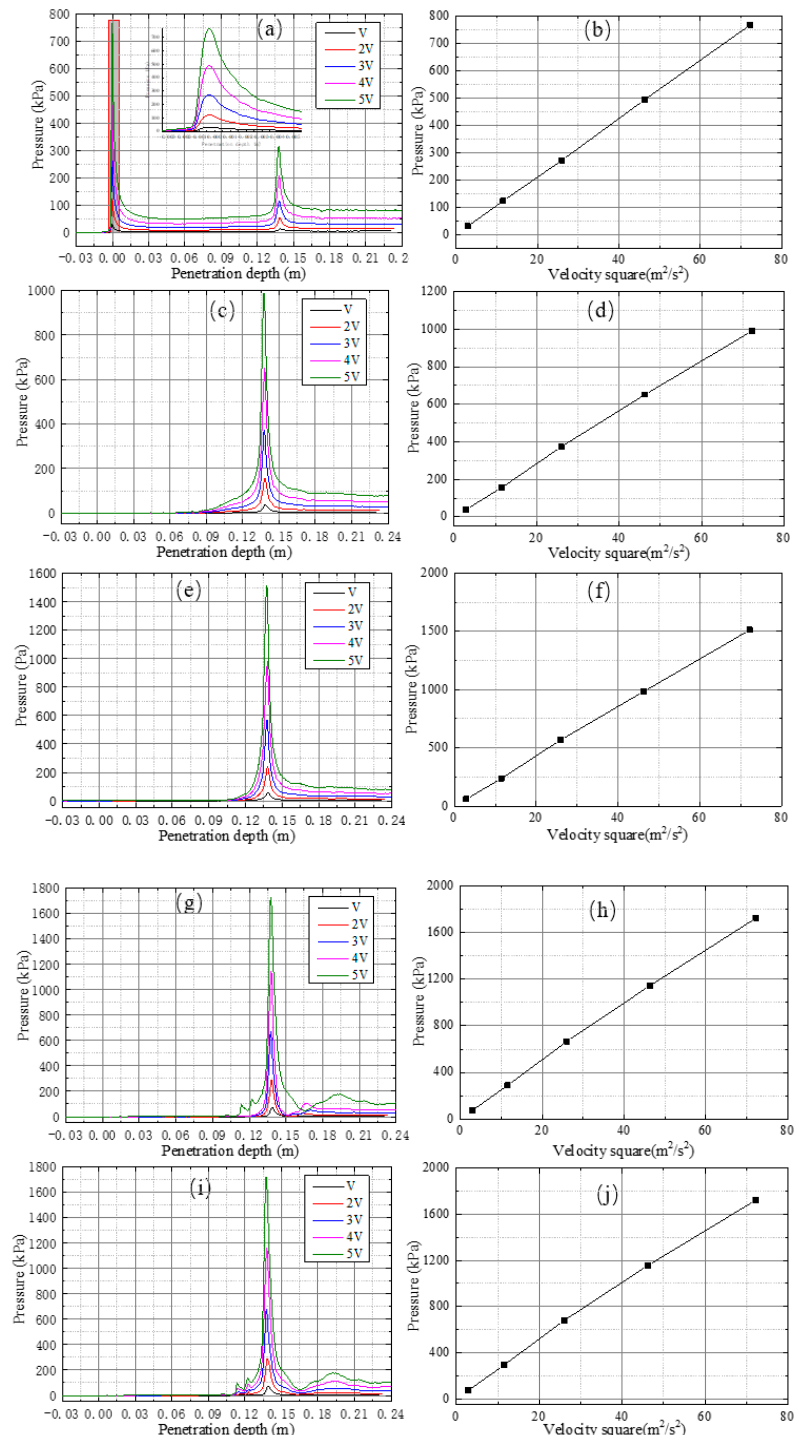
Figure 5. Pressure varying with penetration depth with different constant entry velocities, and the relation between pressure peak values and square of corresponding entry velocities (( a , c , e , g , i ): pressure vs. penetration depth at five monitoring points with different entry velocities; ( b , d , f , h , j ): peak pressures values vs. square of the entry velocity at five monitoring points).